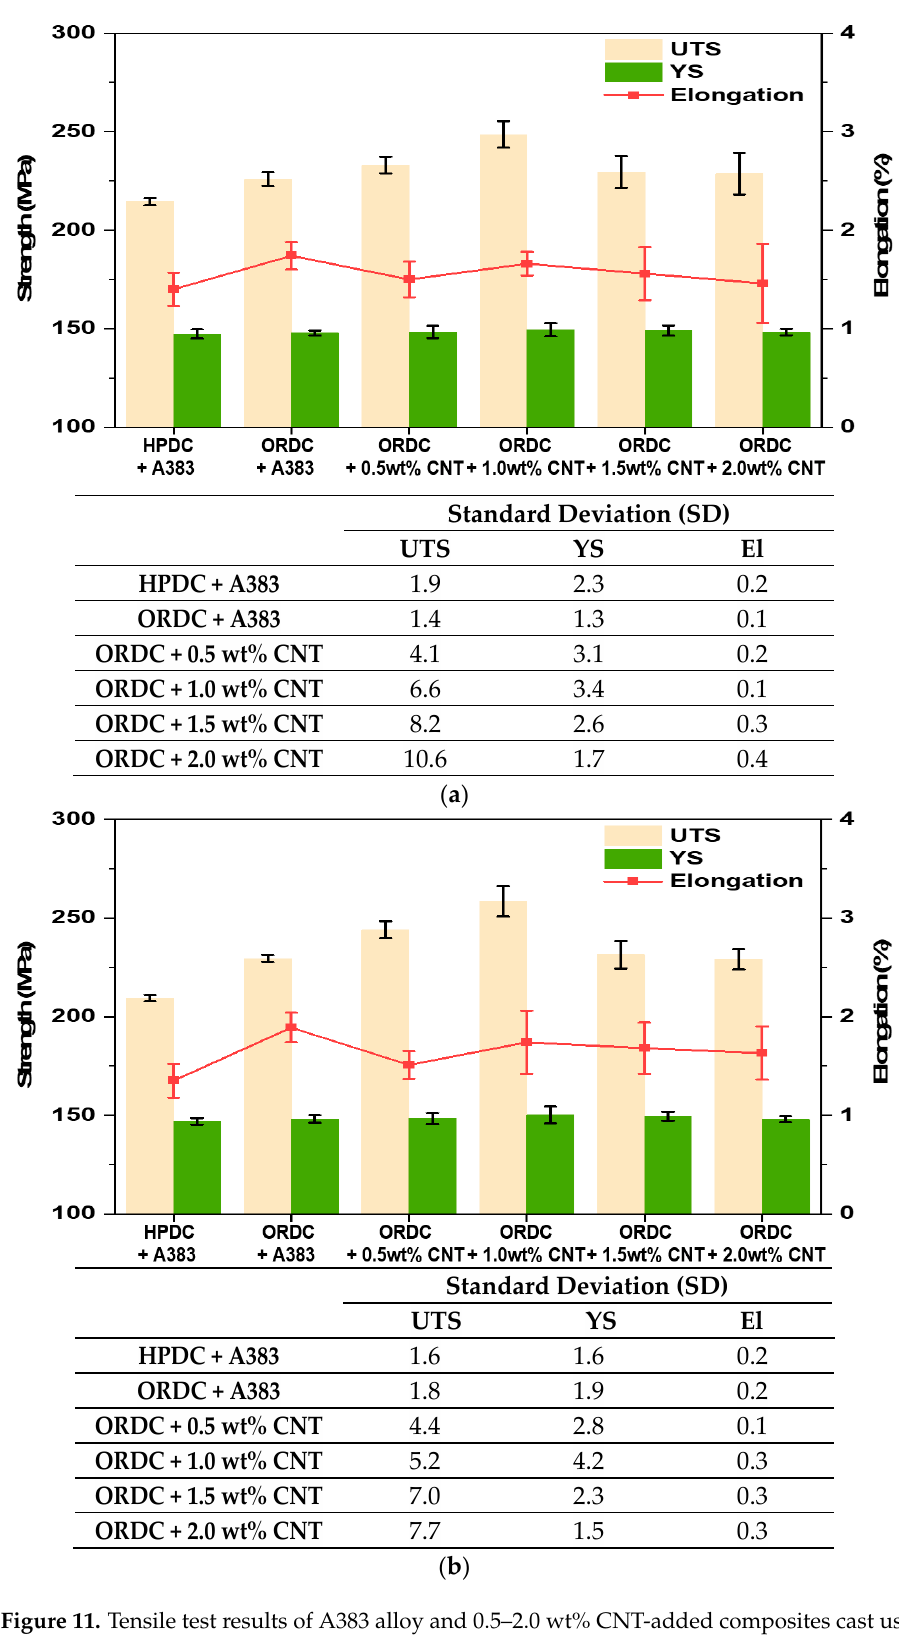
Figure 11. Tensile test results of A383 alloy and 0.5–2.0 wt% CNT-added composites cast using ( a ) a single gate and ( b ) poly gate by using HPDC and